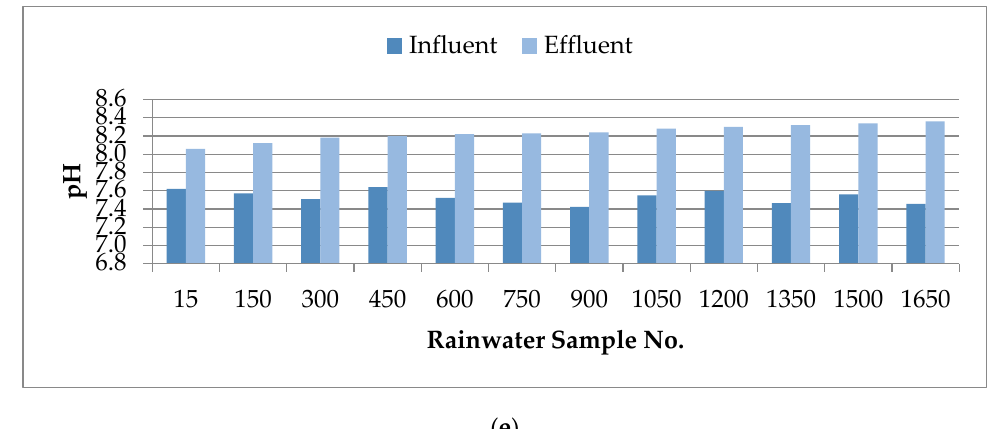
Figure 13. The e ffi ciency of experimental filter media used in recharge well. The comparison of ( a ) TSS; ( b ) Total Hardness; ( c ) Magnesium; ( d ) Calcium; and ( e ) pH parameters before and after passing the filter media